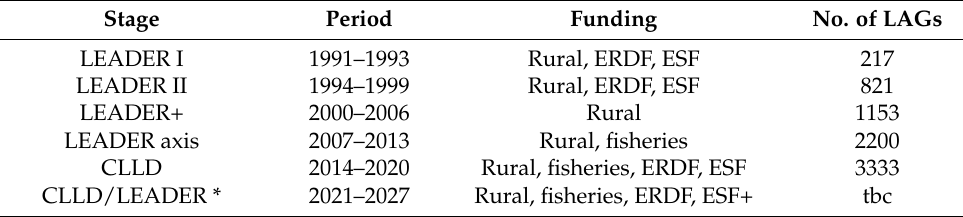
Table 1. Evolution and expansion of the LEADER approach into